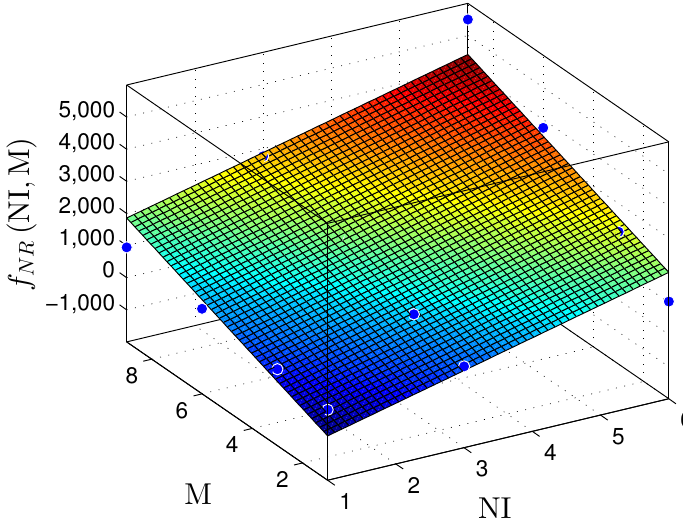
Figure 16. Plane f NR ( NI , M ) that estimates the NR, as a function of the NI and M, for the linear regression prediction technique.